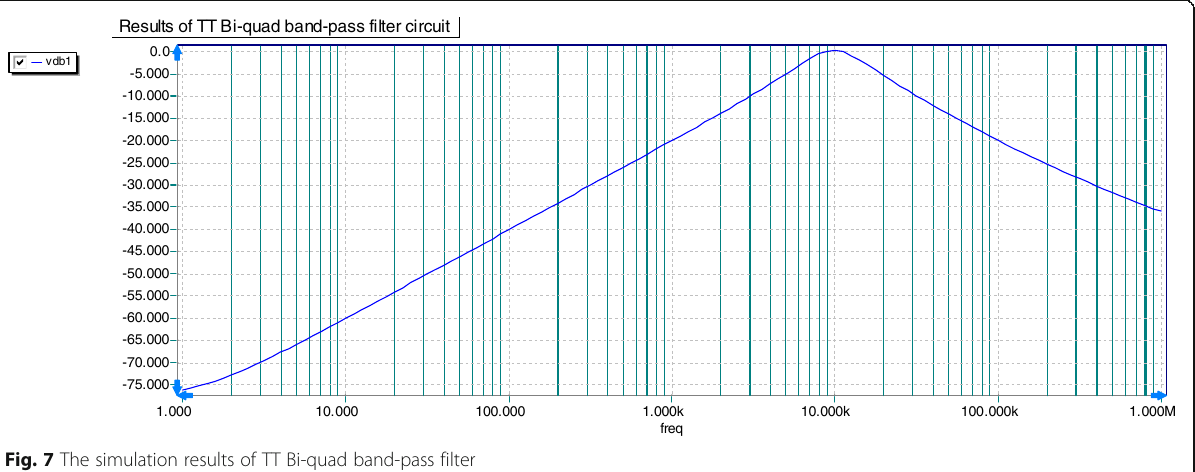
Fig. 7 The simulation results of TT Bi-quad band-pass filter